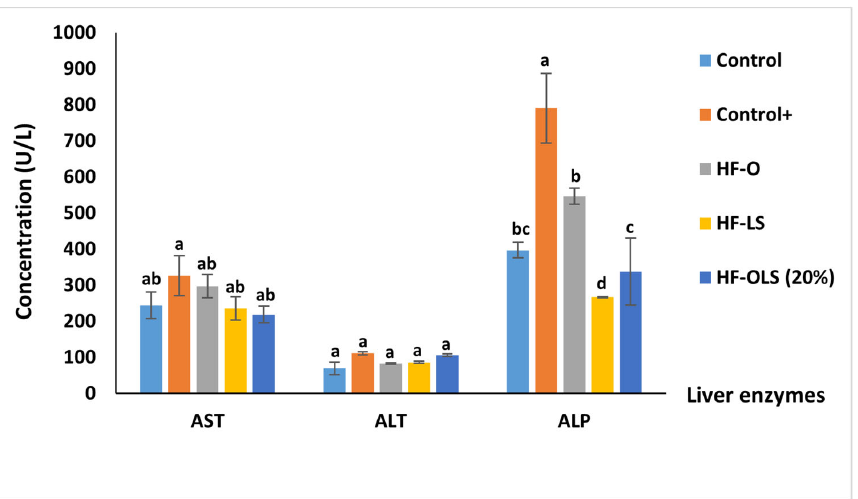
Figure 7. Liver enzymes: AST (aspartate transaminase), ALT (alanine transaminase), and ALP (alkaline phosphatase) of rats fed with standard diet, high fat diet, and high fat diet and juice for three months. Control (rats fed with a standard diet), Control+ (rats fed with a high-fat diet composed by mixing a standard diet with 20% of vegetarian ghee), HF-O (rats fed with a high-fat diet and 9 mL/kg/day of orange juice), HF-LS (rats fed with a high-fat diet and 9 mL/kg/day of beetroot leaf–stem juice), HF-OLS (20%) (rats fed with a high-fat diet and 9 mL/kg/day of orange juice mixed with 20% of beetroot leaf–stem juice). Columns of each enzyme labeled with different letters are significantly different at ( p < 0.05).